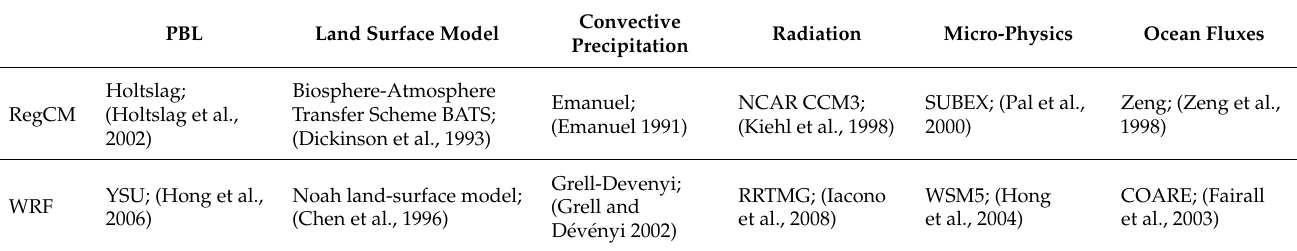
Figure 1. Geographical domain for the D01 ( a ) and D02 ( b ) simulations and related grids. Table 1. Main numerical schemes adopted in RegCM and WRF